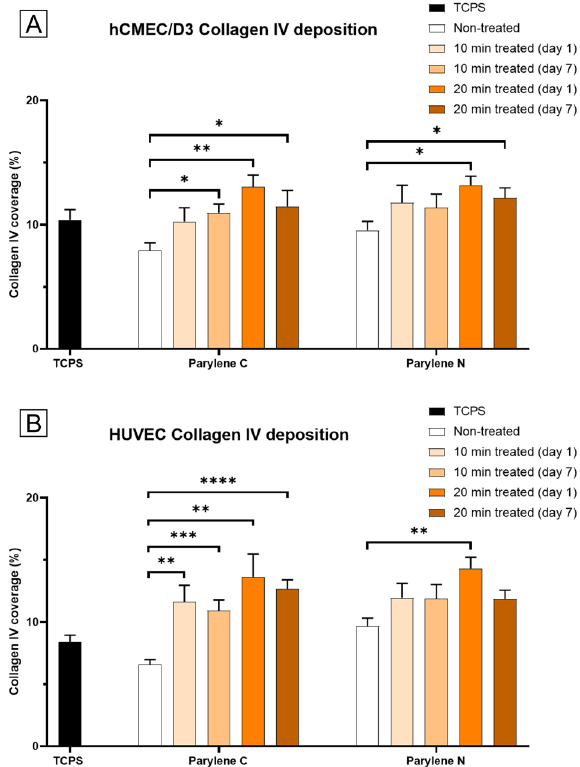
Figure 6. Changes in collagen IV deposition by vascular endothelial cells on Parylene C and Parylene N membranes result from plasma treatment. ( A ) hCMEC/D3 collagen IV coverage on TCPS, Parylene C, and Parylene N membranes. ( B ) HUVEC collagen IV coverage on TCPS, Parylene C, and Parylene N membranes.